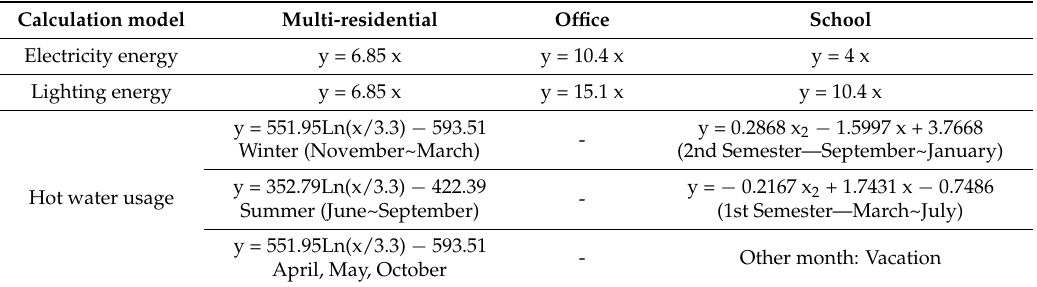
Table 4. Multi-regression equation for reference building performance calculation(x: Area (m 2 ))